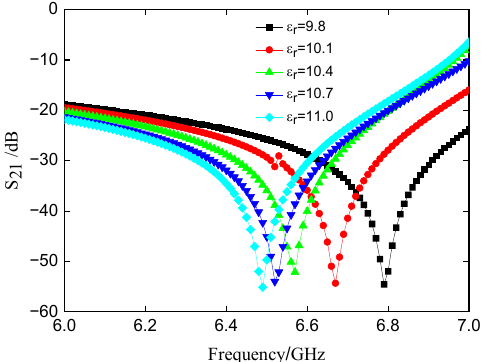
Figure 5. Variation of resonant frequency with different dielectric constants.